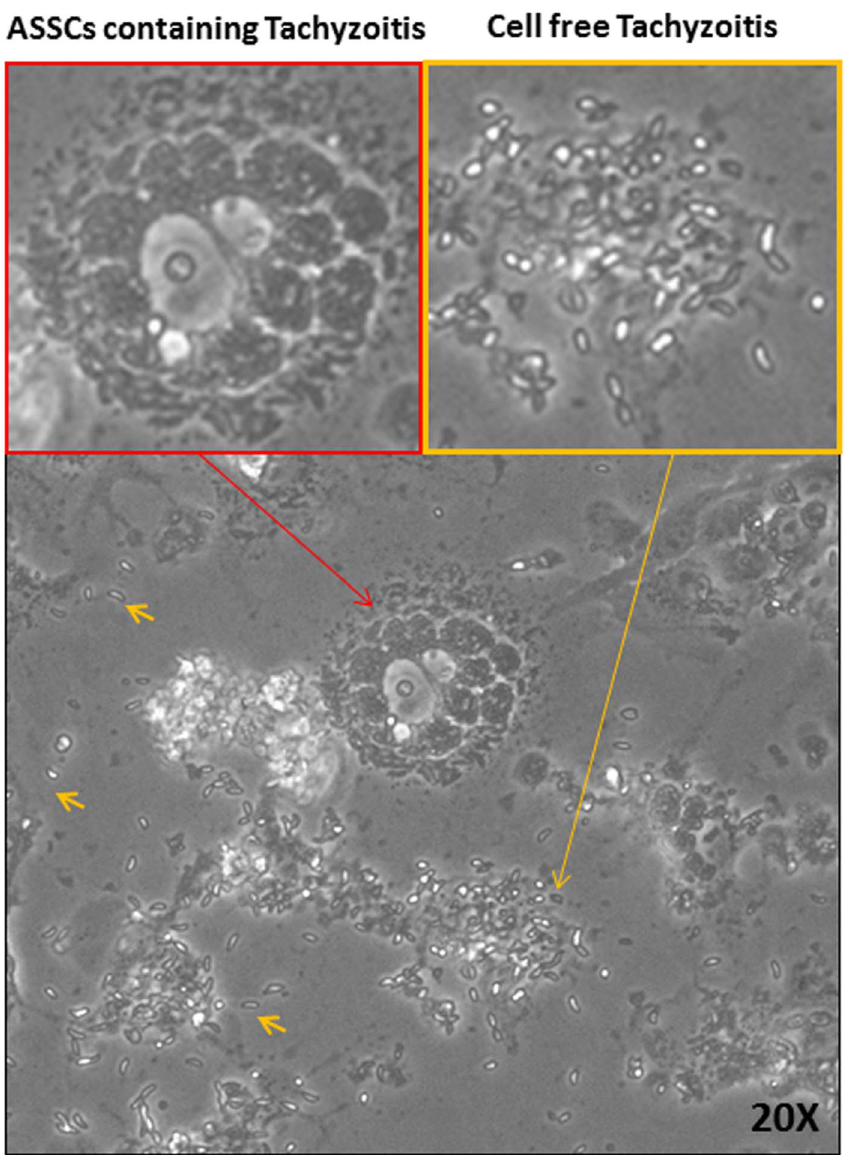
Figure 4. Neosporacaninum infection of ASSCs. Representative phase contrast image (20x) of ASSCs containing Neospora caninum tachyzoites and cell free Neospora caninum tachyzoites at 48 h post